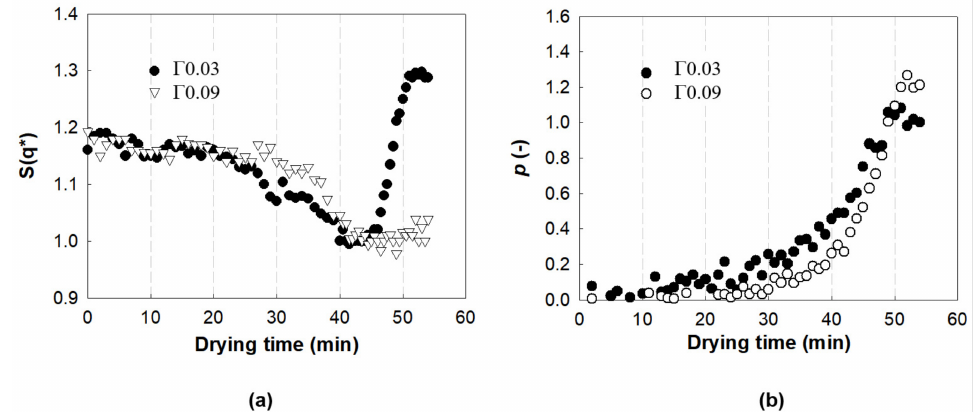
Figure 7. Analysis of I(q) and S(q). ( a ) Peak height, S(q*), of S(q), and ( b ) power law slope of I(q) calculated in the q range between 0.12 and 0.18 nm − 1 .